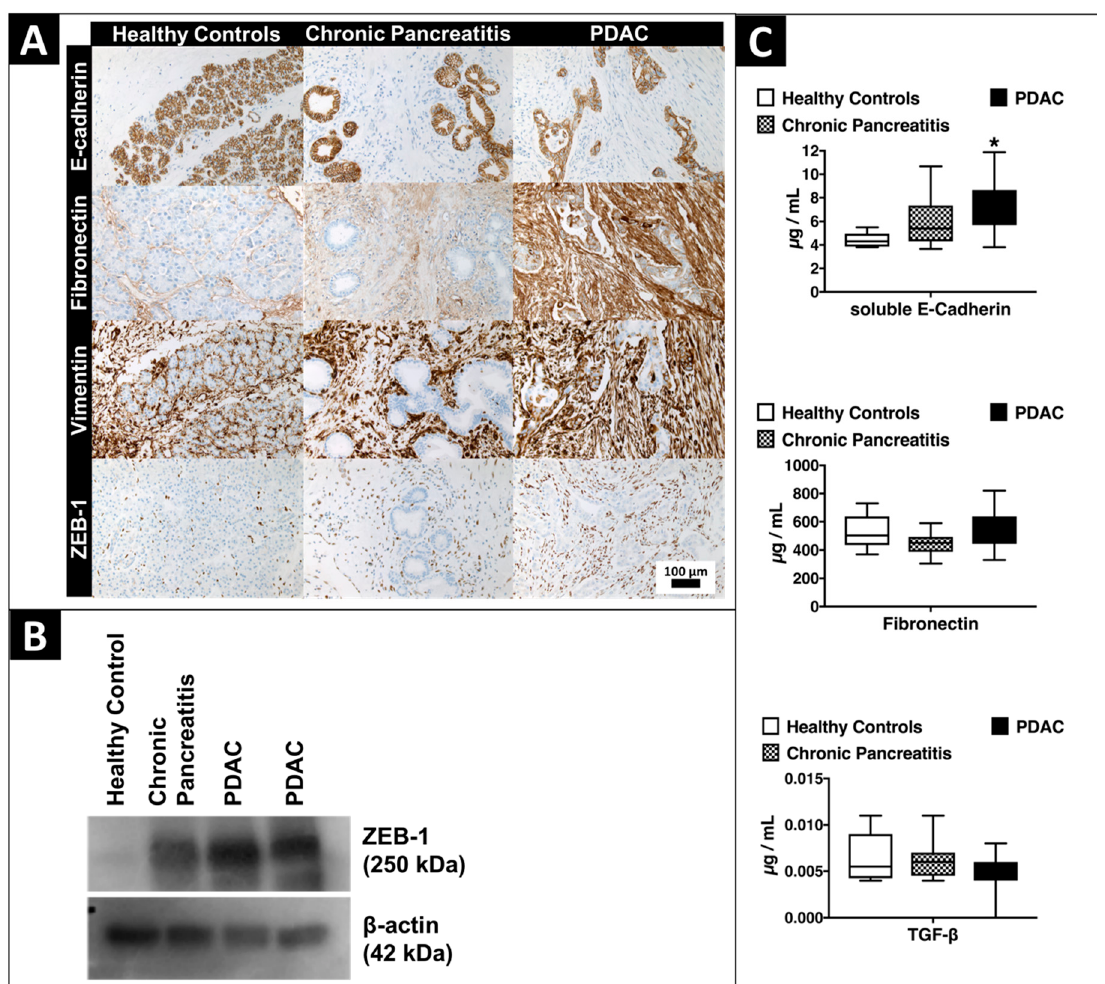
Figure 3. EMT-marker protein expression in human pancreatic tissue and blood serum samples. ( A ) IHC staining of the epithelial marker E-cadherin, mesenchymal markers vimentin, fibronectin and the transcription factor ZEB-1 in human PDAC and healthy pancreatic tissue. Scale bar: 100 μ m. ( B ) Protein expression of ZEB1 in macrodissected tissue specimens analyzed with Western blot. ( C ) EMT-marker protein analyzed in blood serum samples by Enzyme-linked Immunosorbent Assay (ELISA). * indicates significance ( p ≤ 0.05) against healthy controls.